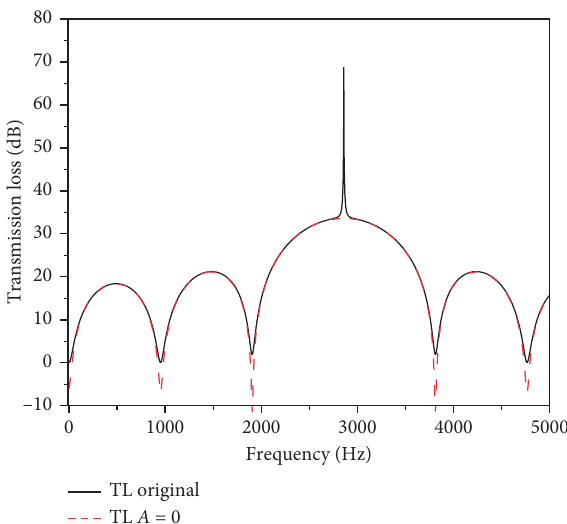
Figure 5: Quadrupole parameter analysis of the side outlet muffler ( C � 0).